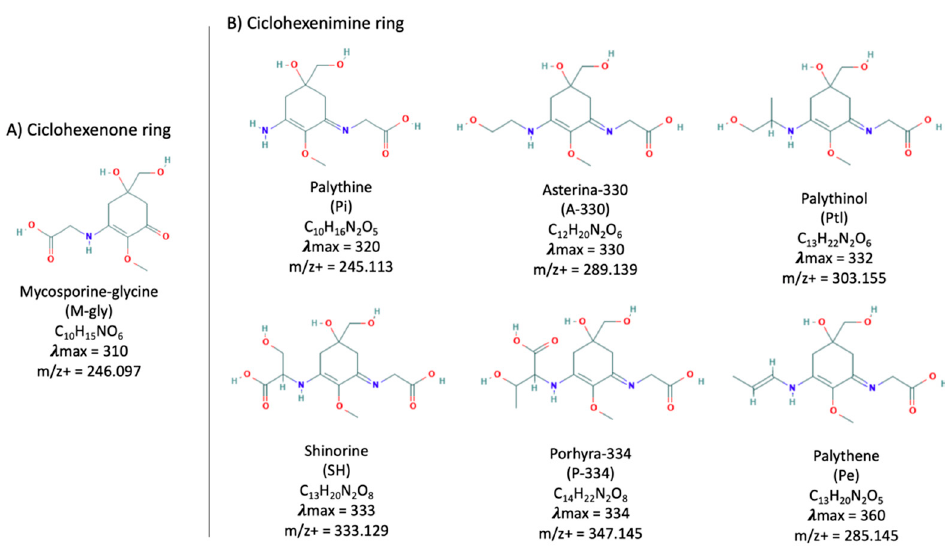
Figure 1. Chemical structure of the most common MAAs found in red macroalgae [20,21,34–40].